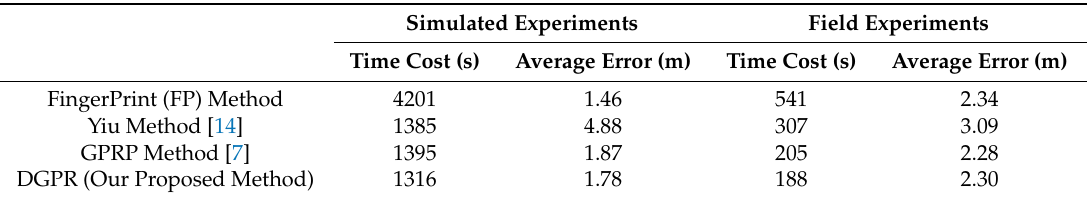
Table 4. Total performance of four comparison